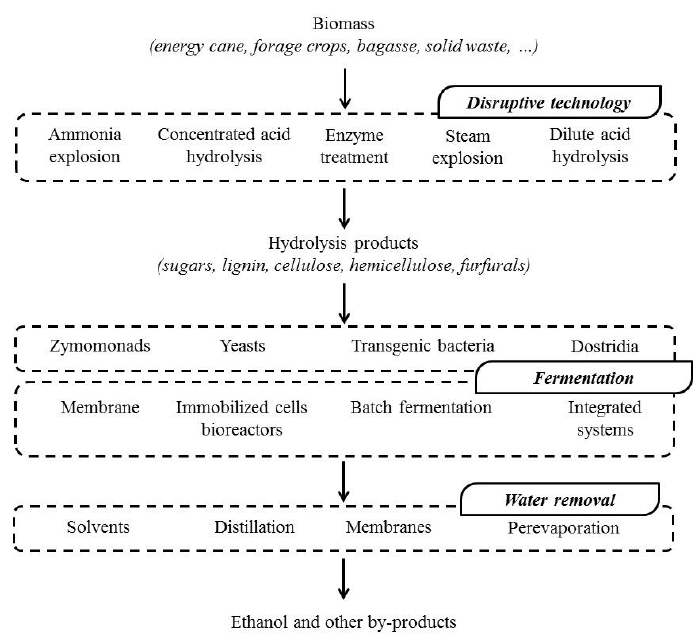
Figure 1. Biomass to ethanol conversion options, adapted by